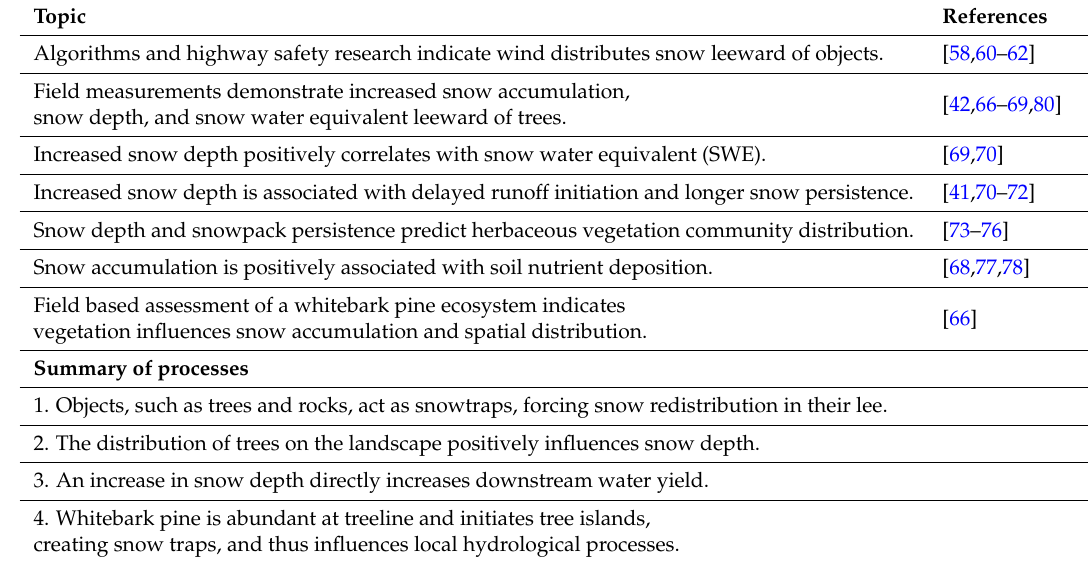
Table 4. References describing snowpack deposition, redistribution, snowmelt run-off, and the role of high elevation tree communities in these processes. The processes are summarized with respect to potential snow retention ecosystem services provided by whitebark pine communities in the alpine-treeline ecotone.